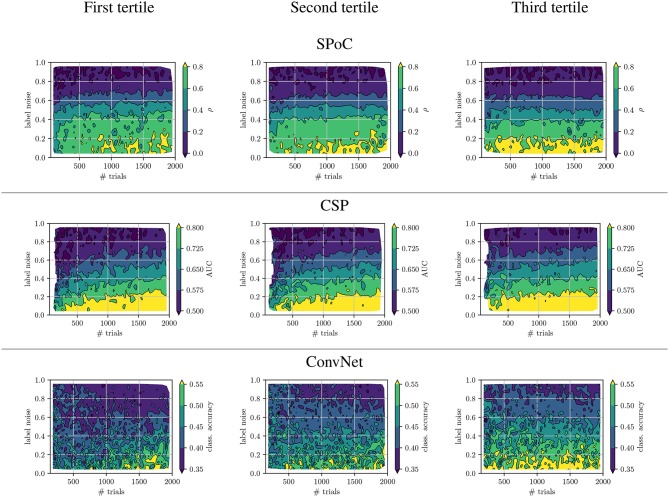
Biparametrical analysis of performance wrt. to tertile membership of the target variable z variance.